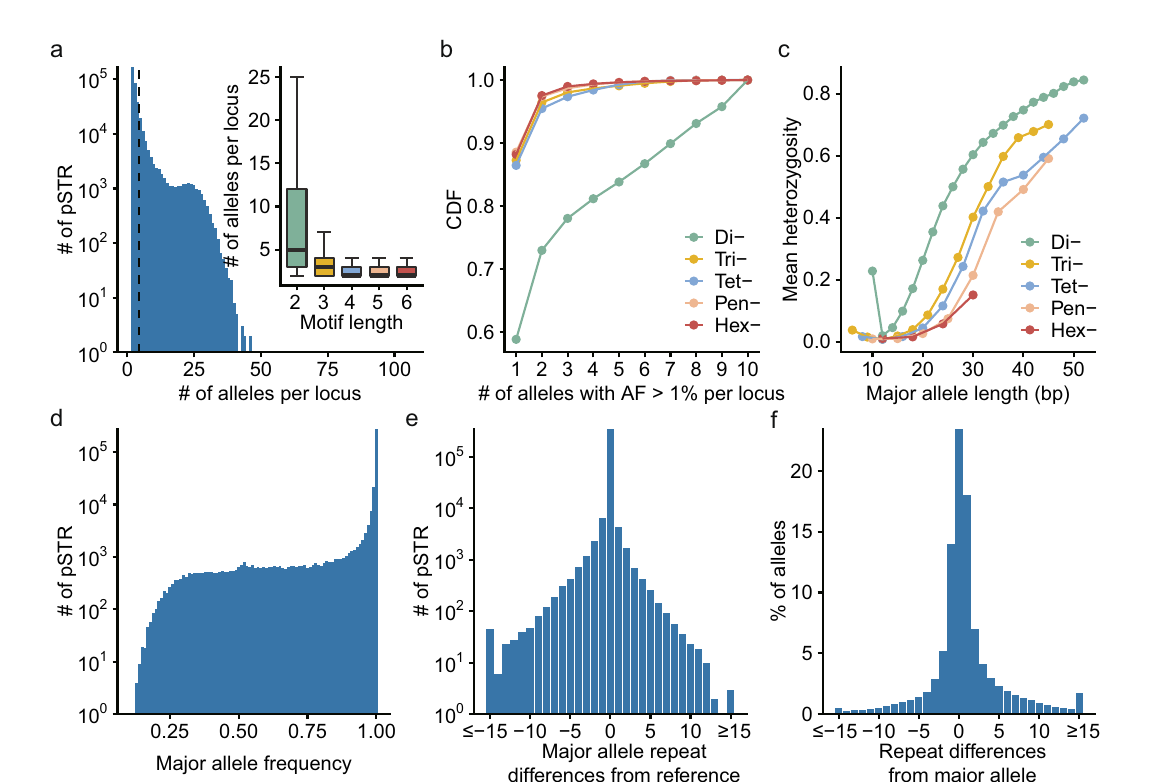
Fig.1|pSTRidenti fi edinthisstudy.a ThecumulativenumberofpSTRlocibroken down by dataset, superpopulation, and STR types. b Comparison of the pSTR loci (upper) and pSTR alleles (lower) identi fi ed from the NyuWa dataset with those